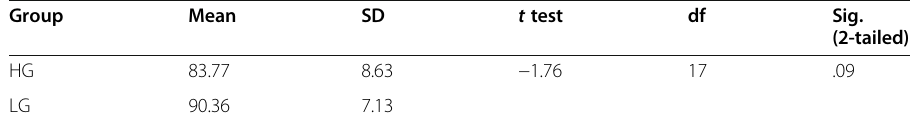
Table 2 Descriptive statistics and the independent samples t test of the two groups of teachers ’ students ’ scores